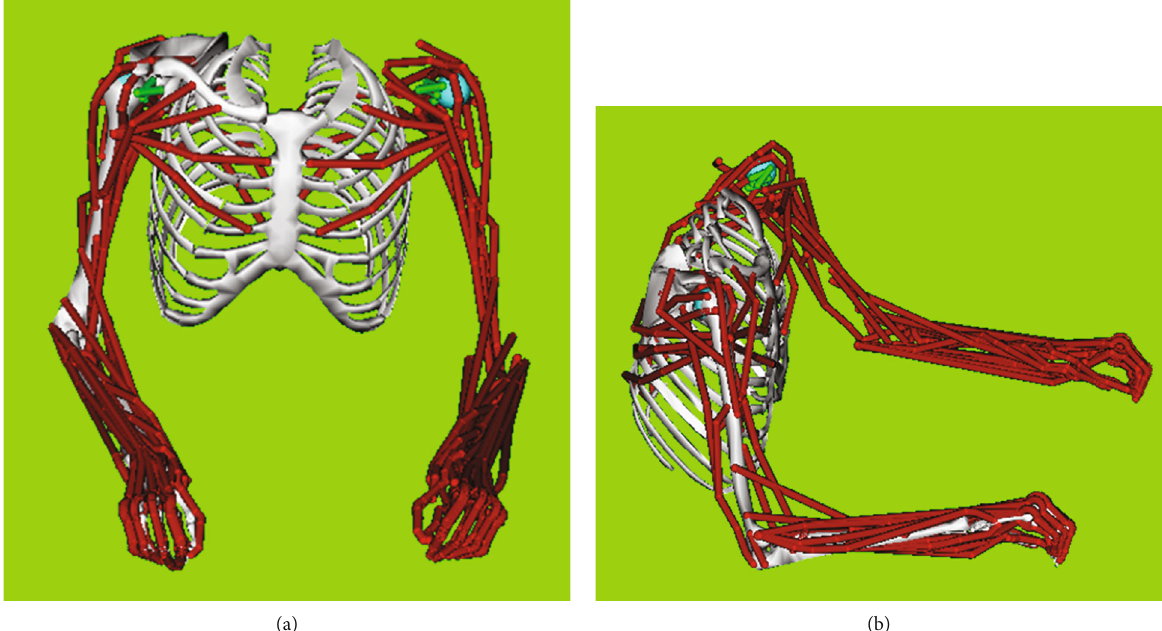
Figure 1: Anterior (a) and lateral (b) view of OpenSim upper limb model.